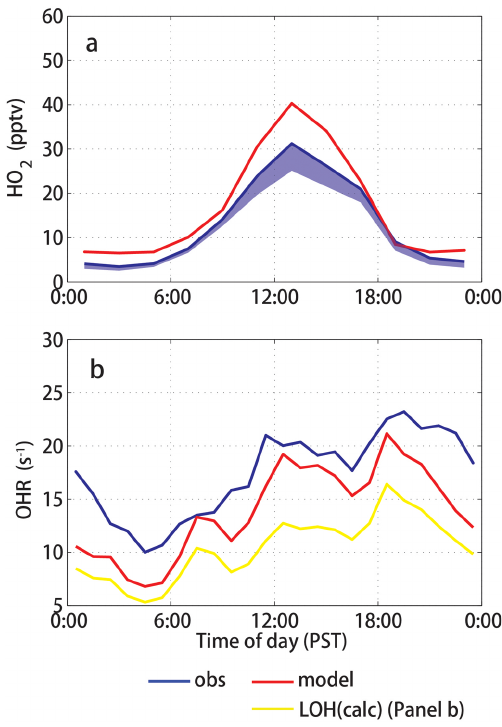
Fig. 4. Diurnal cycle of HO 2 (a) and OH reactivity (b) between 20 June and 30 July 2009 near the Blodgett Forest Research Station (BFRS). In the top panel, the shaded area below measured HO 2 (blue solid line) indicates the contribution to measured HO 2 from an RO 2 interference from isoprene, MVK and MACR (Fuchs et al., 2011). In the bottom panel, the calculated OH reactivity from avail- able measurements (LOH) is represented by a yellow line. The ab- solute uncertainty of the HO 2 measurements is ± 40% at 2 σ con- fidence. The absolute uncertainty of OH reactivity measurement is 1s − 1 at 2 σ confidence (Mao et al., 2009). The model incorporates the current understanding of BVOC oxidation chemistry (see text for details).